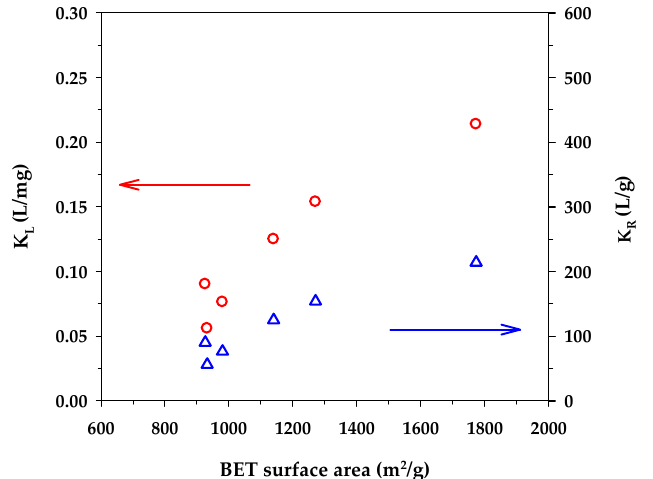
Figure 6. Effect of BET surface area on K L of the Langmuir equation and K R of the Redlich–Peterson equation. Table 7. Parameters of adsorption isotherm equations for MB adsorption at 35 ◦ C by the prepared activated